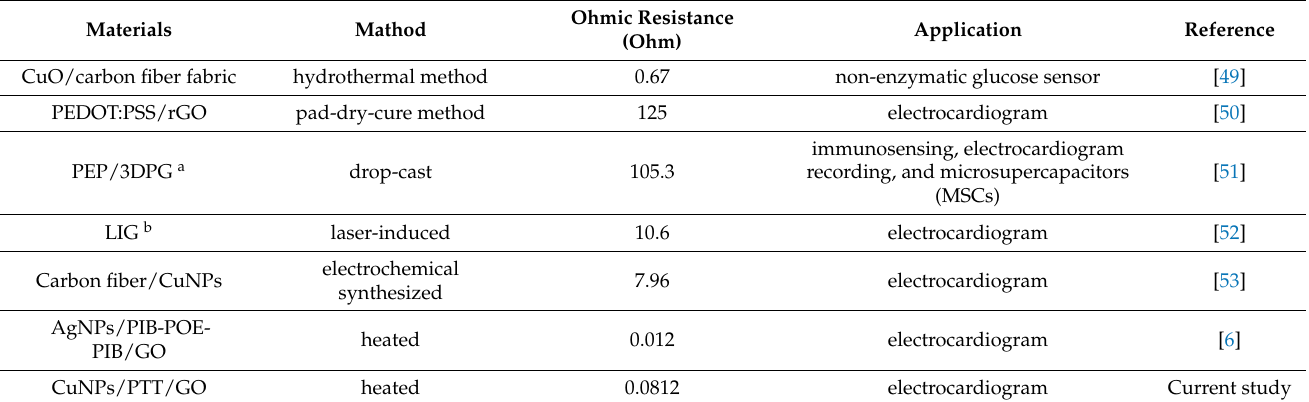
Table 2. Performance comparison of present hybrid films with those reported in the literature.